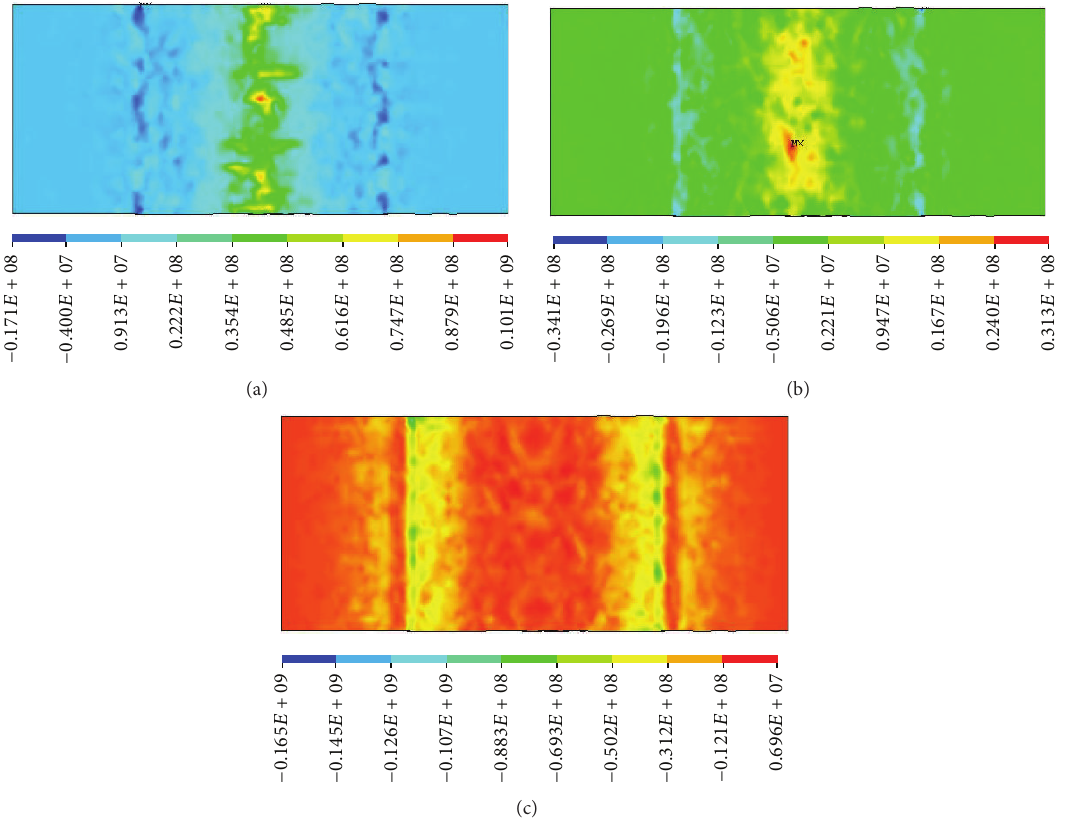
Figure 8: Bottom skin stress distribution: (a) 1st principal stress; (b) 2nd principal stress; (c) 3rd principal stress.